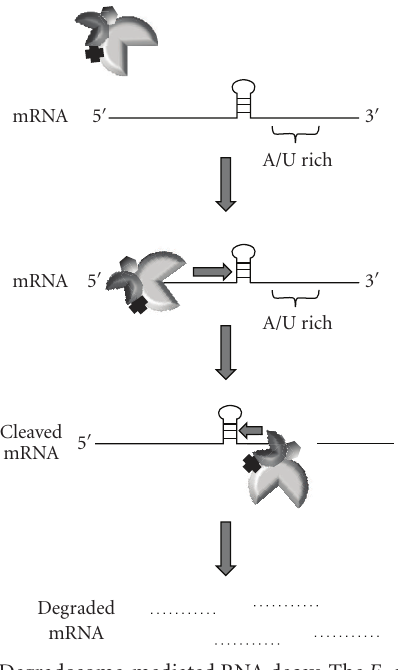
Figure 1: Degradosome-mediated RNA decay. The E. coli degrado- some is composed of at least four subunits: RNase E, PNPase, RhlB helicase, and enolase. The initial RNA cleavage event is catalyzed by the 5 (cid:2) → 3 (cid:2) endoribonuclease RNase E (large cut-out circle) which loads onto a transcript and scans for downstream cleavage sites: A/U rich regions proceeded by stem-loop structures in 5 (cid:2) monophosphorylated transcripts. The 3 (cid:2) → 5 (cid:2) exoribonuclease PNPase (small cut-out circle) catalyzes cleavage of RNase E- generated decay intermediates. Otherwise inhibitory secondary structures to PNPase-mediated degradation are resolved by RhlB helicase (cross). The role of enolase (hexagon) in mRNA decay is not well